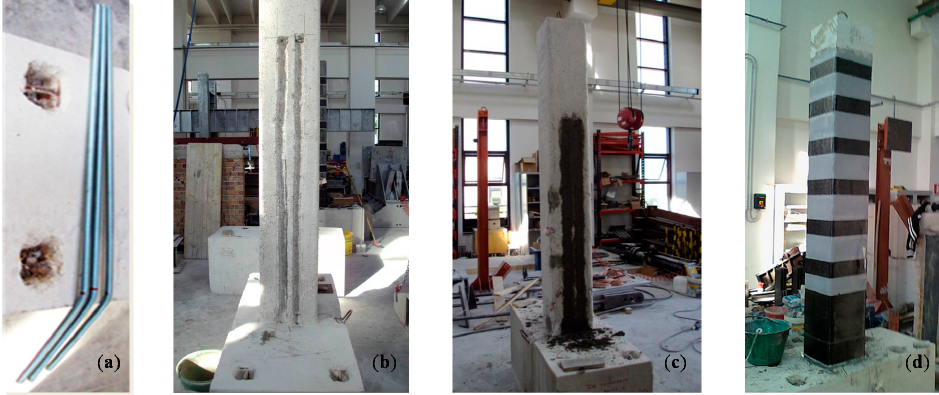
Figure 3. Strengthening procedure: layout “type A”.